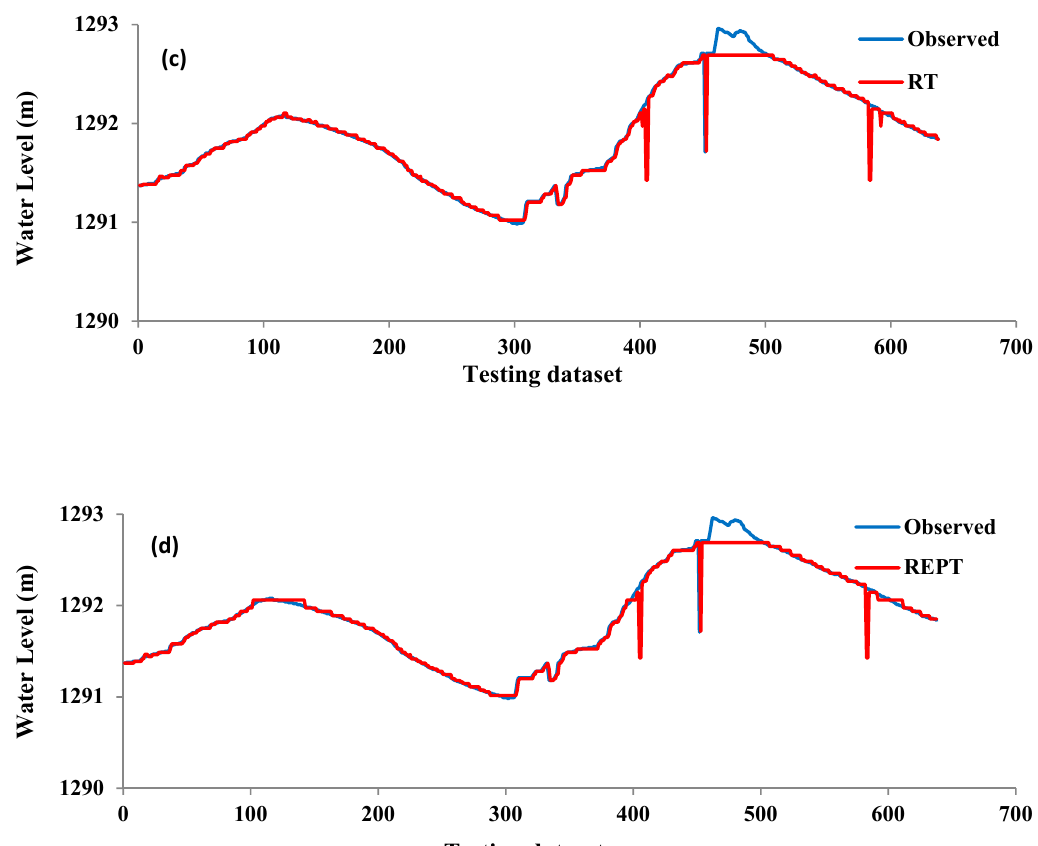
Figure 3. Line graphs of observed and predicted daily water levels of different models in the testing phase: ( a ) M5P; ( b ) RF; ( c ) RT; ( d ) REPT.